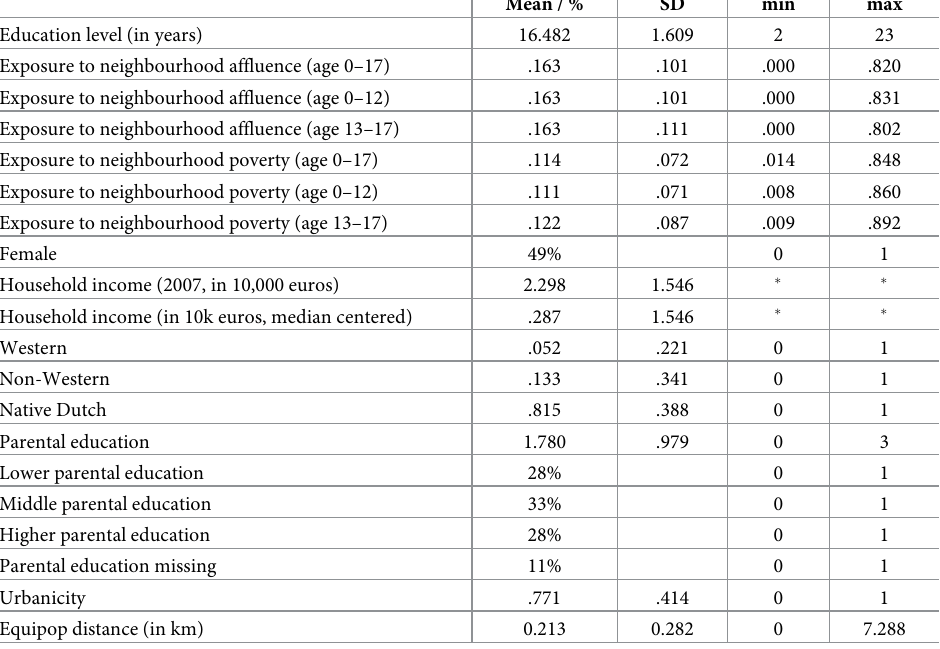
Table 1. Descriptive statistics ( N =